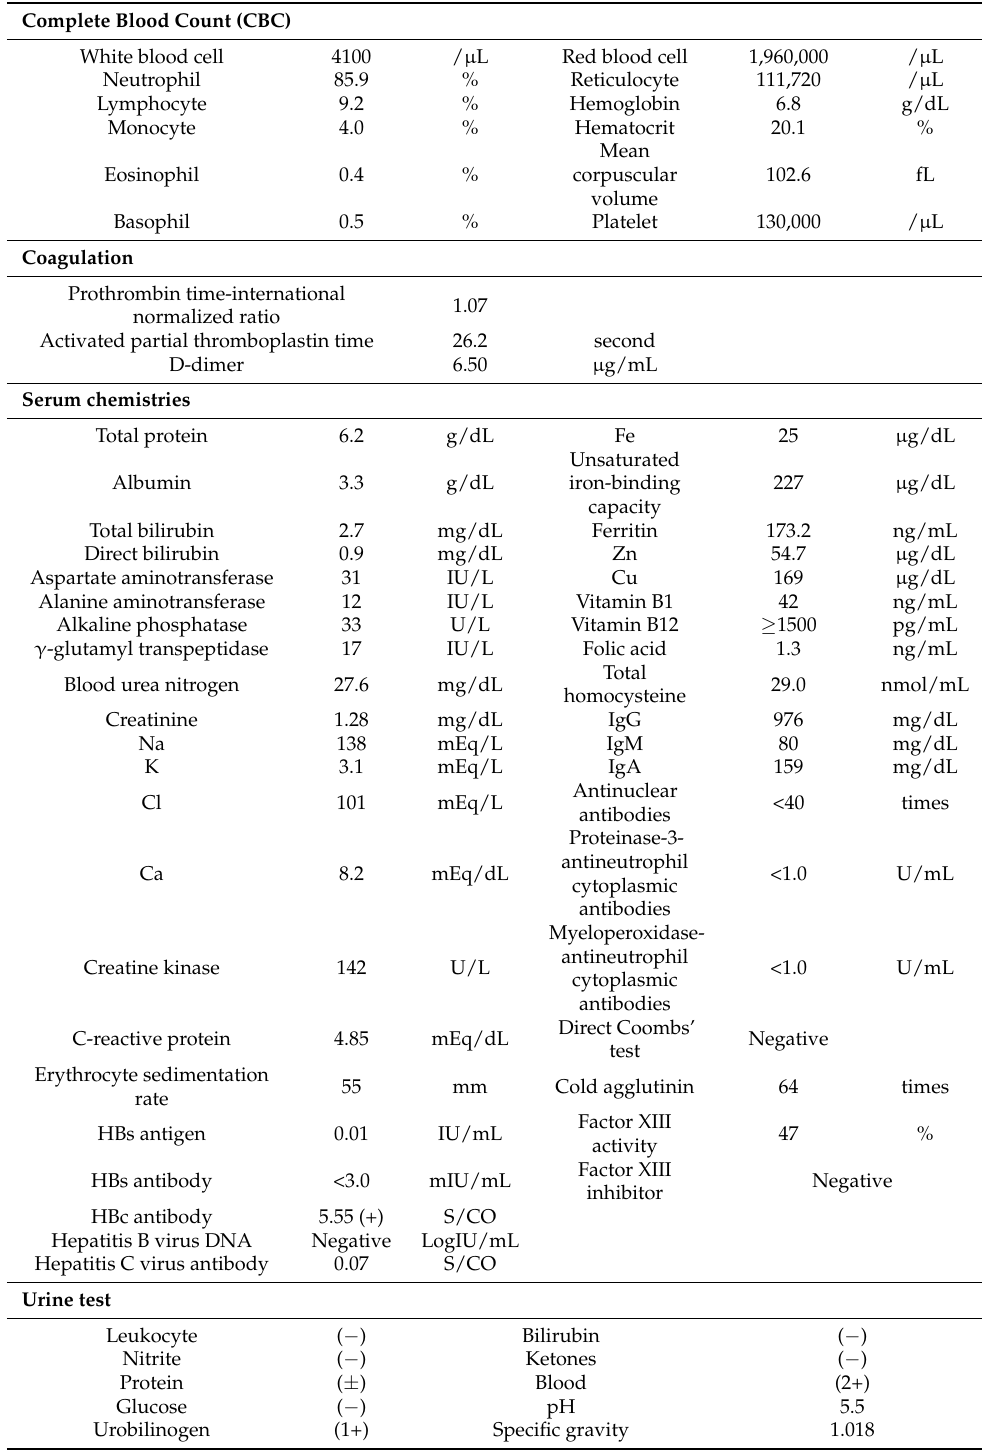
Table 3. Laboratory test results.